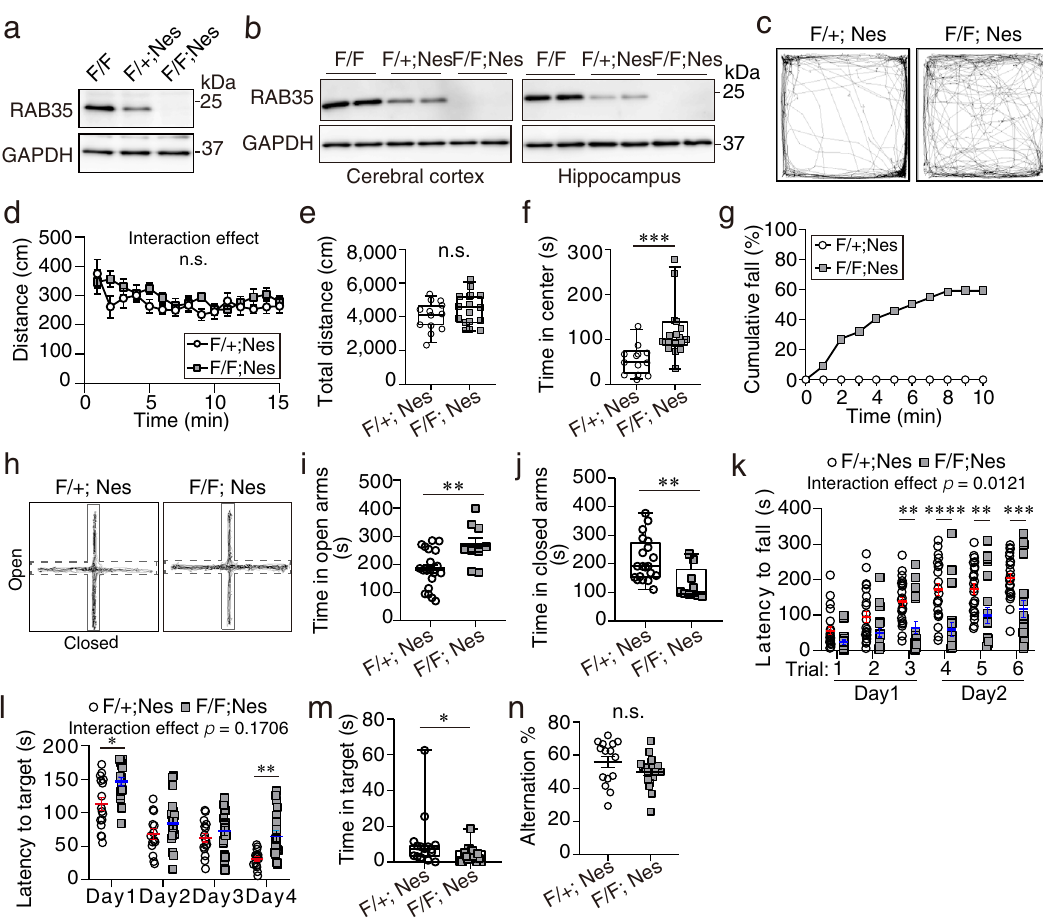
Fig. 2 Characterization of CNS-speci fi c Rab35 conditional knockout mice. a , b Western blot analysis of E13.5 ( a ) and 4-month-old ( b ) Rab35 fl ox/ fl ox , Rab35 fl ox/ + ; Nestin-Cre , and Rab35 fl ox/ fl ox ; Nestin-Cre mouse brain lysates. c – f Open fi eld test in control ( n = 13) and Rab35 cKO ( n = 17) mice. c Typical traces of the horizontal locomotor activity. d Distance traveled per minute. Two-way repeated-measures ANOVA; interaction effect, F (14, 392) = 1.094, p = 0.3612. e Total distance traveled. Mann – Whitney test, p = 0.3. f Stay time in the center area. Mann – Whitney U -test, p < 0.001. g – j Elevated plus maze in control ( n = 20) and Rab35 cKO ( n = 22) mice. g Cumulative percentage of mice falling from open arms. h Typical traces in the elevated plus maze test. i Stay time in open arms. Unpaired Student ’ s t -test, p = 0.0054. j Stay time in the closed arms. Mann – Whitney U -test, p = 0.0034. k Rotarod test in control ( n = 23) and Rab35 cKO ( n = 20) mice. Two-way repeated-measures ANOVA with Bonferroni correction; interaction effect, F (5, 205) = 3.009, p = 0.0121; trial 3, p = 0.0076; trial 4, p < 0.0001; trial 5, p = 0.0059; trial 6, p = 0.0008. l , m Barnes maze tests in control ( n = 16) and Rab35 cKO ( n = 19) mice. l Latency to reach the target hole. Each point represents the mean of three trials. Two-way repeated-measures ANOVA with Bonferroni correction; interaction effect, F (3, 99) = 1.706, p = 0.1706; day 1, p = 0.0261; day 4, p = 0.0030. m Time spent around the target hole during a 90 s period. Mann – Whitney U -test, p = 0.0136. n Alternation percentages in Y maze test of control ( n = 15) and Rab35 cKO ( n = 18) mice. Unpaired Student ’ s t -test, p = 0.01454. Data represent mean ± SEM or box and whisker plots; box plot shows 25th and 75th percentiles (box), median (horizontal bar), and minimum to maximum (whiskers); n.s. not signi fi cant ( p > 0.05); * p < 0.05; ** p < 0.01; *** p < 0.001; and **** p < has a six-layered structure. During cortical development, excita- tory neurons are generated from radial glial cells in the ven- tricular side 34,35 . Newly born neurons radially migrate from the apical ventricular side toward the basal pial surface and stop migrating just beneath the marginal zone. Therefore, early-born neurons form the deep layer (layers VI and V), whereas late-born neurons pass through the deep layer and settle in more super fi cial layers (layers IV – II); hence, the proper six-layered structure of the cerebral cortex is formed in a birthdate-dependent inside-out manner 36,37 . Cortical neurons are segregated into cell layers with neurons formed around the same period and expressing layer- speci fi c transcription factors, including chicken ovalbumin upstream promoter transcription factor-interacting proteins 2 (Ctip2; a marker for layer V) and cut homeobox 1 (Cux1; a marker for layer II – IV), to differentiate and establish layer- dependent neural connections.